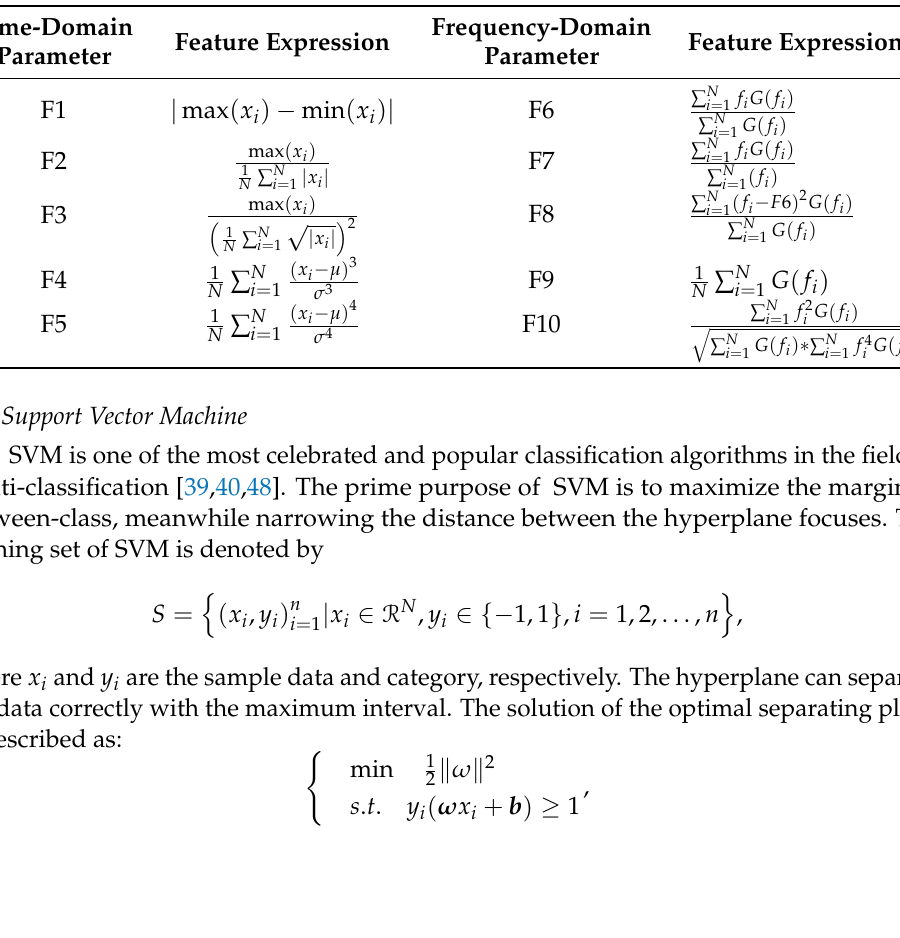
Table 1. The expression of feature